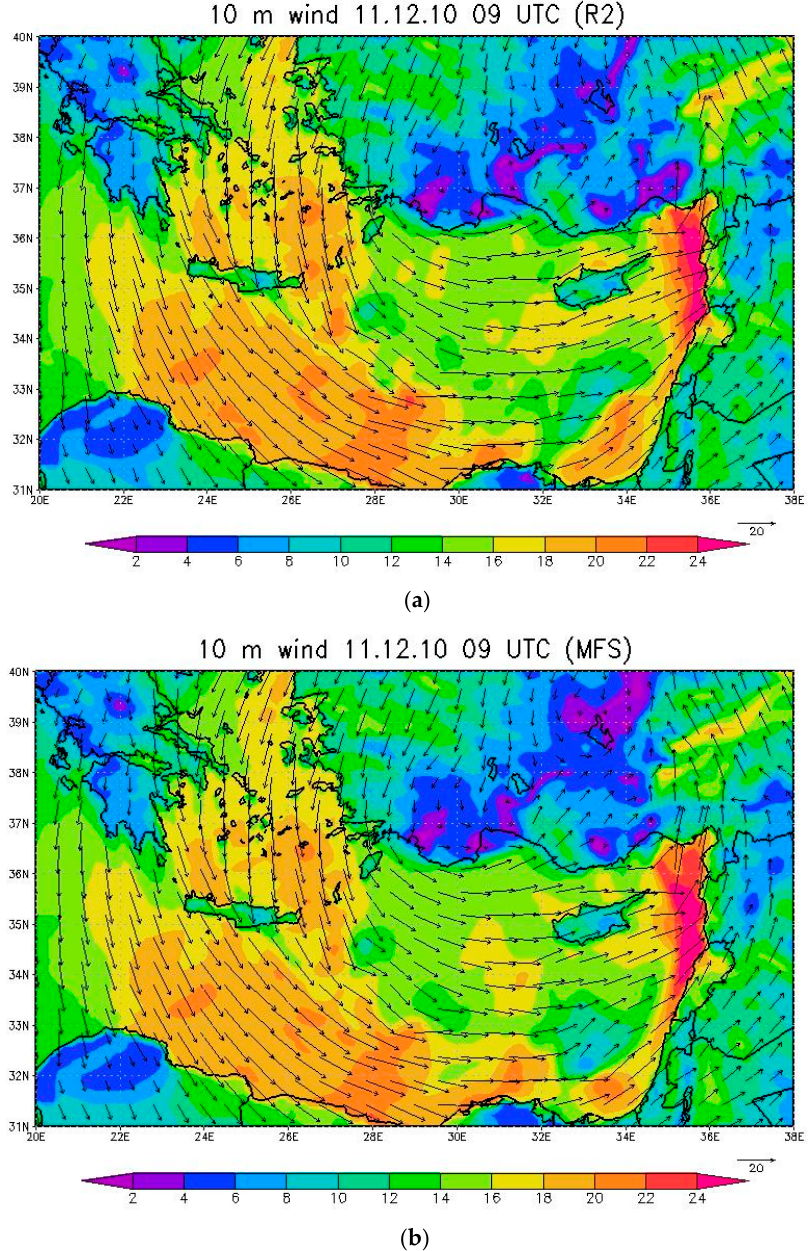
Figure 26. 10 m winds on 11 December 2010 09 UTC from ( a ) the R2 run and ( b ) the MFS run. Speeds in ms − 1 .